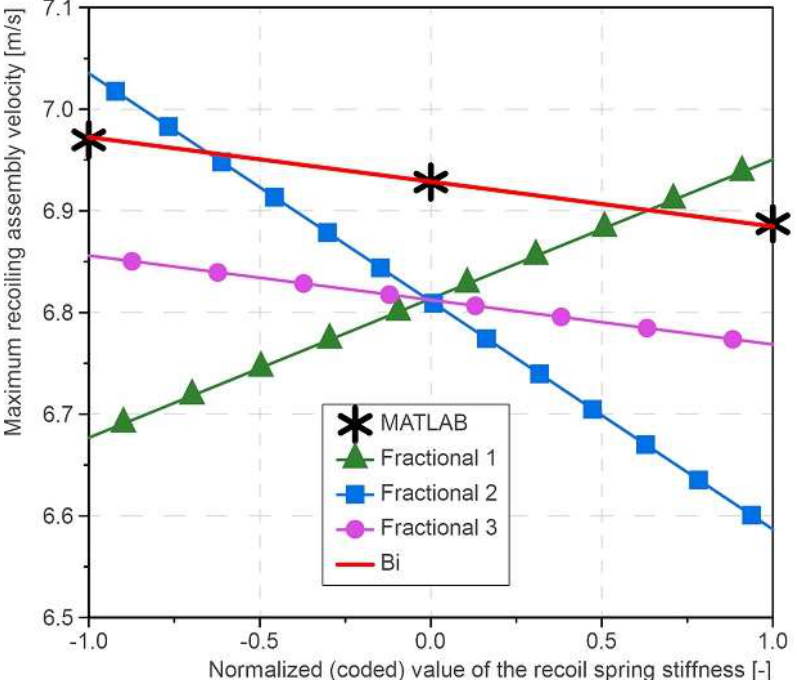
Figure 6. Diagram of the maximum recoiling assembly velocity as a function of the normalized (coded) value of the recoil spring stiffness. (coded) value of the recoil spring